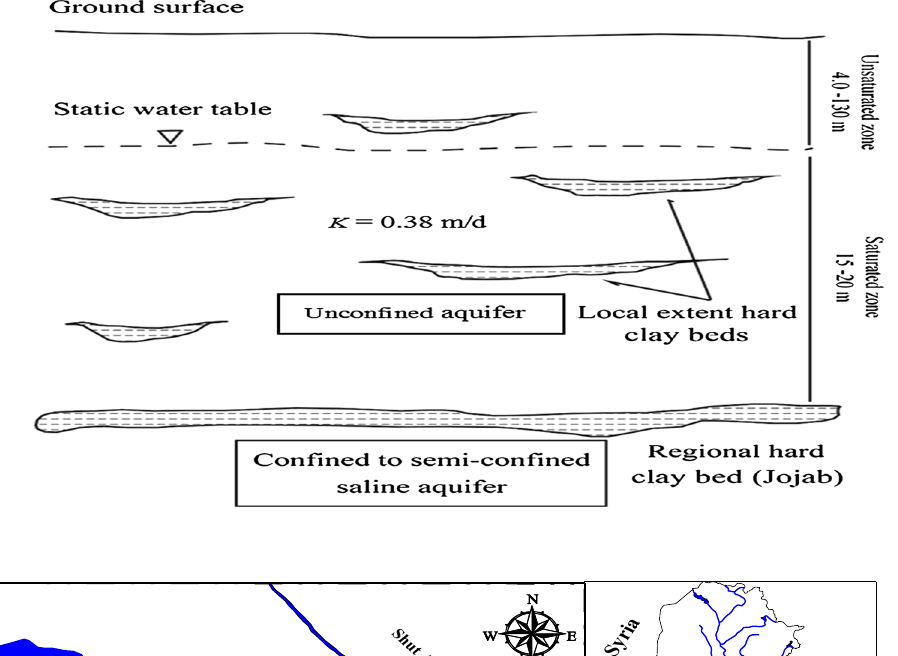
Fig. 3 Prototype of aquifer